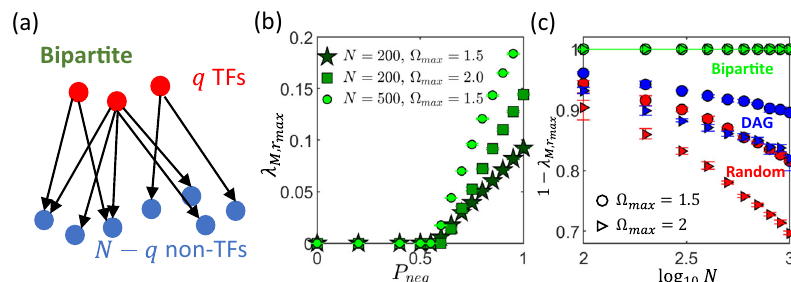
Fig. 3 Stability of bipartite networks. a When constructing a bipartite interaction network, we group the proteins into transcription factors (TFs, red circles) and non-TFs (blue circles), and only allow directed regulatory interactions to go from a TF to a non-TF. b For bipartite networks, there is a critical value for the fraction of inhibitory interactions P neg (that is slightly > 0.5) below which the maximal real part of the eigenvalues of the interaction matrix λ ¼ 0 and above which λ λ ¼ 0 (which can be considered to be deeply stable since it is far from the point M ; r max M ; r max > 0. In the regime where M ; r max λ ¼ 1 where the system becomes unstable), this value of λ M ; r max M ; r max stays the same even when the number of different proteins N (star markers vs. circles) or interaction strengths Ω max (star markers vs. squares) are increased. c When there is an equal fraction of up/downregulatory interactions P neg = 0.5, λ Ω ‘ Random ’ , red markers) and M ; r max is independent of both N and max for bipartite networks (green markers). This is in contrast to fully random networks ( ¼ 1) as N or Ω random directed acyclic graphs ( ‘ DAG ’ , blue markers) where the system approaches the instability limit ( λ M ; r max (circles to triangles) is max increased. This implies that a bipartite network structure can maintain and enhance the stability of the system as N or Ω max is increased. In both ( b ) and ( c ), each data point is obtained from an average of 10 randomly drawn networks, with error bars indicating the interquartile range. [Other parameters: h = 1, ρ = 0.01 for fully random and random DAGs, number of TFs for bipartite networks q = 0.1 N